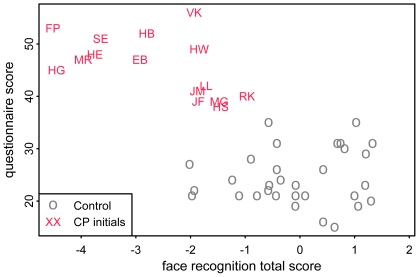
Correlation of experimentally tested deficits and self-assessment.Scores in questionnaire based self-assessment and overall residuals in experimental tests of face recognition performance are correlated in CPs (ρ = −0.55, p = 0.0345).